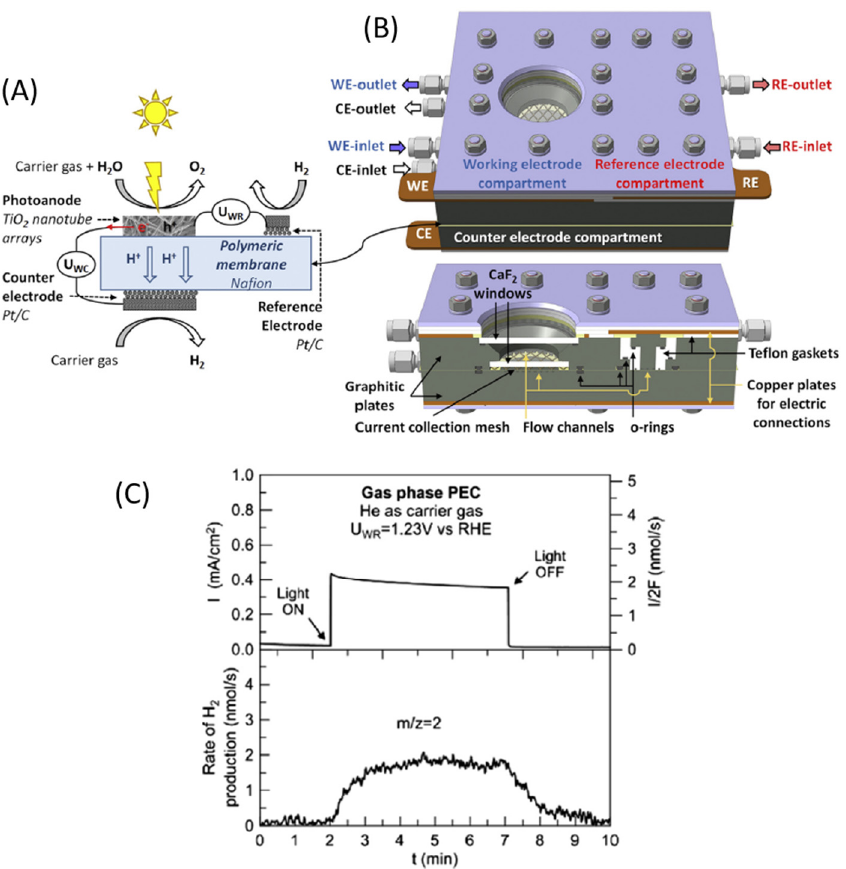
Figure 3. ( A ) Configuration and operation of the membrane (photo)electrode assembly. ( B ) Reactor design with three compartments for accommodating anode, cathode, and reference electrodes (top). The intersection of the reactor presenting the sealing and the electrical isolation between the containers (bottom). ( C ) Detection of hydrogen generation during a step-wise transient illumination experiment. Adapted from [19] .